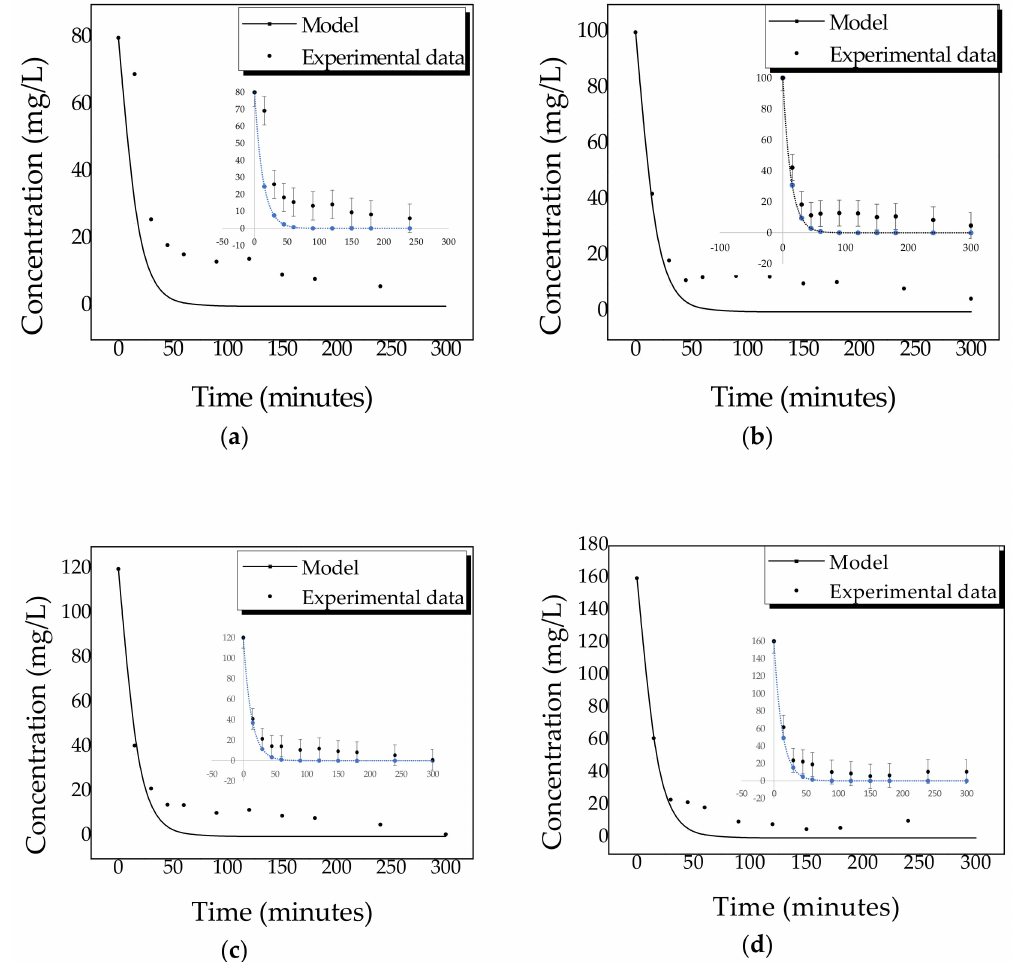
Figure 6. NPEG degradation profile at di ff erent concentrations: ( a ) 80 mg / L, ( b ) 100 mg / L, ( c ) 120 mg / L, and ( d ) 160 mg / L. The curve generated with the application of the first-order model and the experimental data obtained by UV-Vis spectroscopy is shown. In each case, the absolute error value was estimated from the experimental data with respect to the model. For curve ( a ), the error ranges from 5.899–18.304; for the curve ( b ), the error ranges from 4.699–12.591; for curve ( c ), the error ranges from 0.899–12.918; and for curve ( d ), the error ranges from